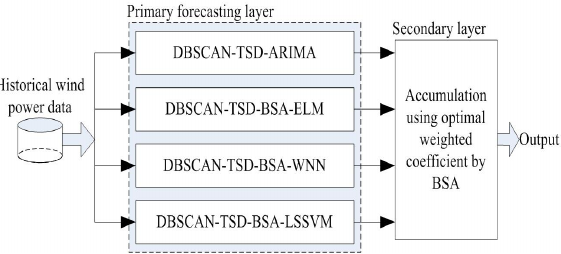
Figure 4. Simplified overall framework of the